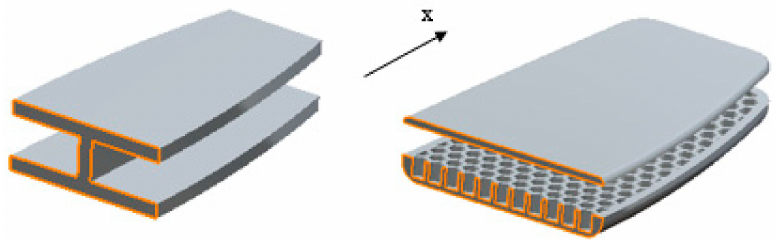
Figure 9. I-shaped beam and the board with equivalent sections shown with orange